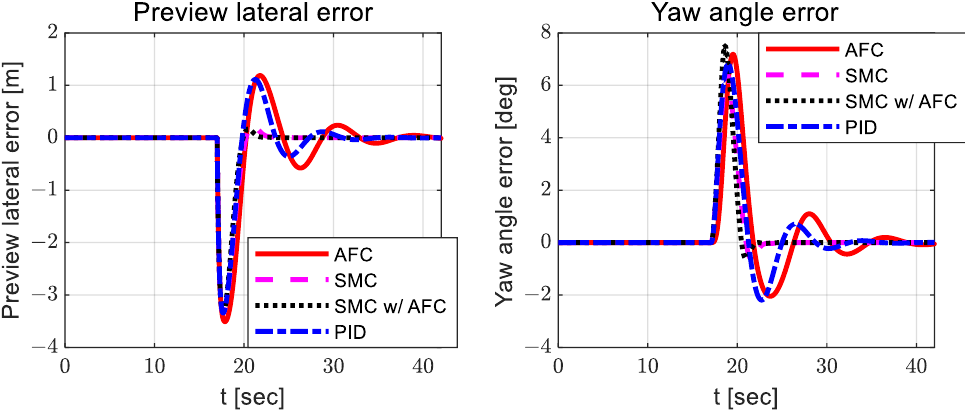
Figure 18. Results: path-tracking control errors (lateral — left ; yaw angle — right ) for the lane change.